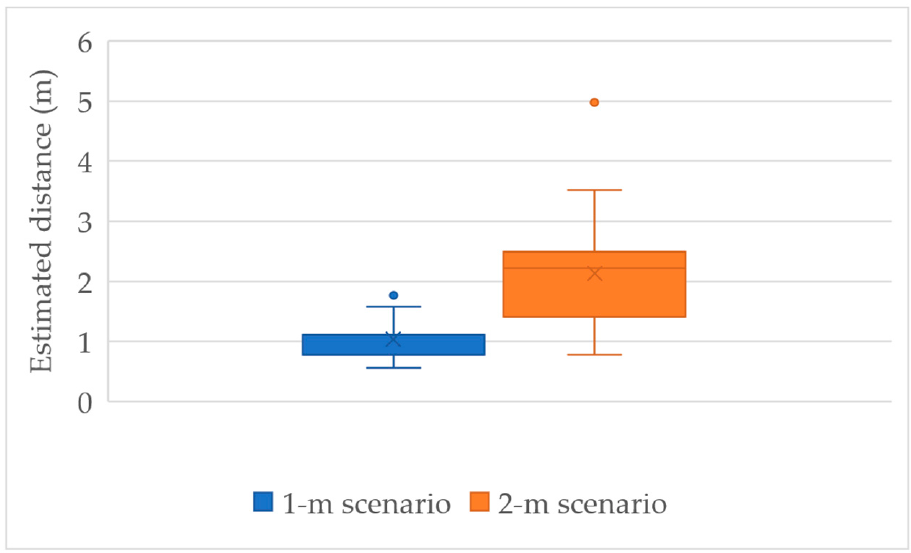
Figure 12. Box plot of the calibrated distance estimation. After the calibrated distance from the UD to every LD is obtained, the UD location can be determined by the WCL method. The localization error statistics of GAR WCL are shown in Figure 13. The y axis is the localization error and the x axis represents different testing location coordinates. The blue color represents the results of WCL using invisible markers without calibration (WCL w/o CAL), whereas the orange color represents WCL using invisible markers with QR code calibration (WCL w/CAL). Based on Figure 13, WCL w/CAL exhibits smaller localization errors than WCL w/o